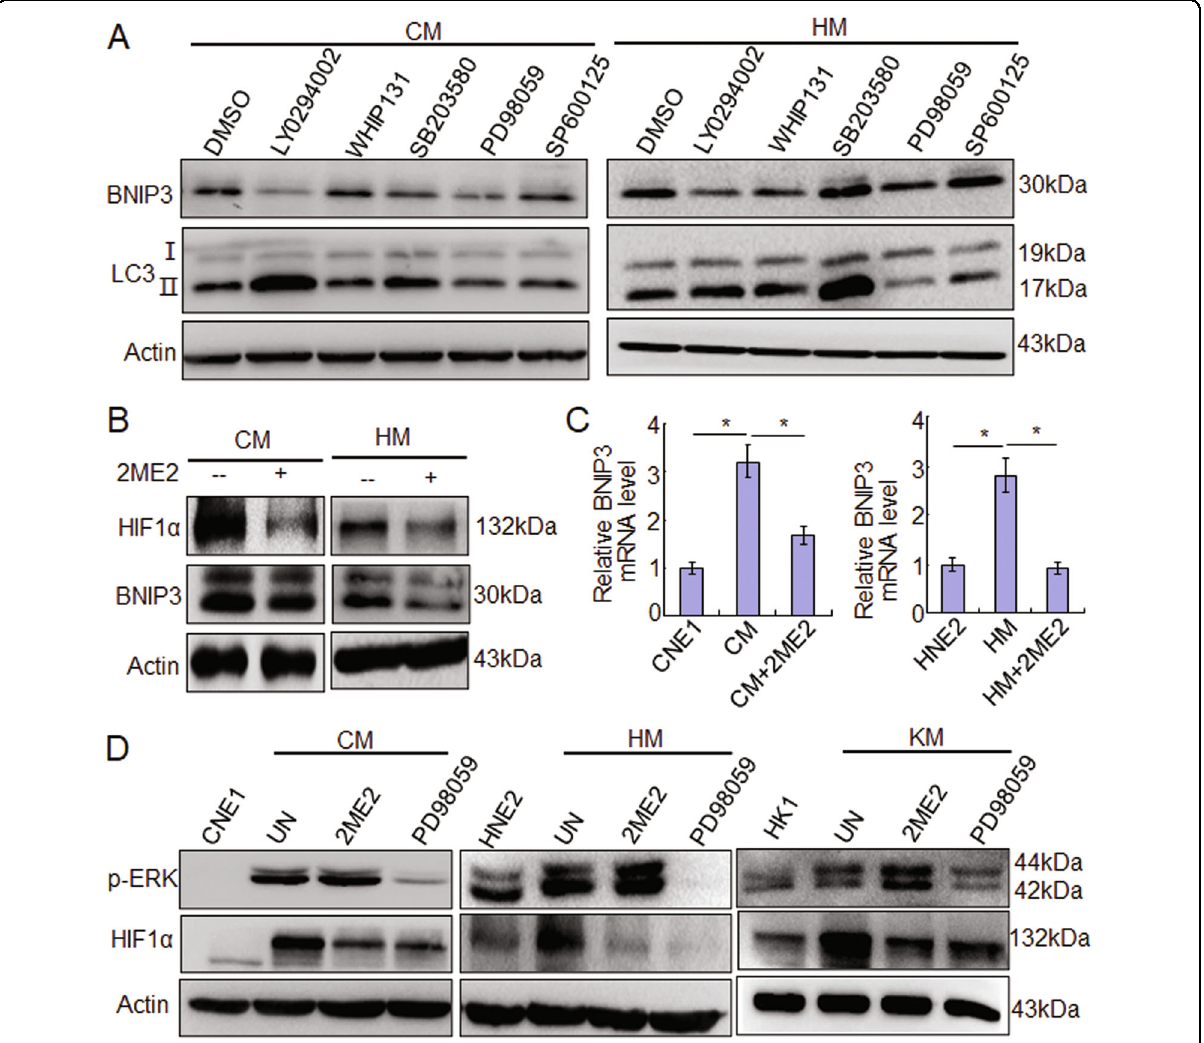
Fig. 5 EBV-LMP1 induces BNIP3 through the ERK/HIF1 α pathway. A After treatment of different inhibitors for 24 h, the expression of BNIP3 and LC3 І / ІІ in NPC cells by Western blots. B After treatment of 2ME2 for 24 h, the expression of HIF1 α and BNIP3 in NPC cells by Western blots. C After treatment of 2ME2 for 24 h, the mRNA expression of BNIP3 in NPC cells by quantitative RT-PCR. Data are expressed as means ± S.D. of three experiments. * p < 0.05. D After treatment of 2ME2 or PD98059 for 24 h, the expression of p-ERK and HIF1 α in CM, HM, and KM cells by Western blots. UN